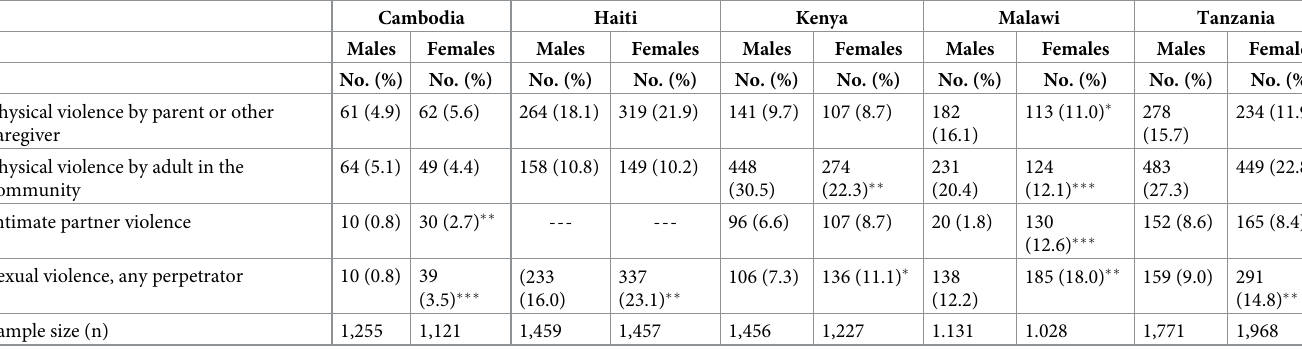
Table 1. Overall sex differences for past-year exposure to violence, all 13–24 year